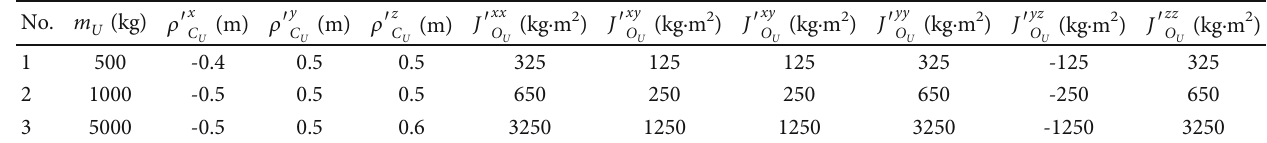
Figure 17: Control force and torque on the base of the space robot: (a) force in X axis, (b) force in Y axis, (c) force in Z axis, (d) torque about X axis, (e) torque about Y axis, and (f) torque about Z axis. Table 3: Inertia parameters of the unknown targets.